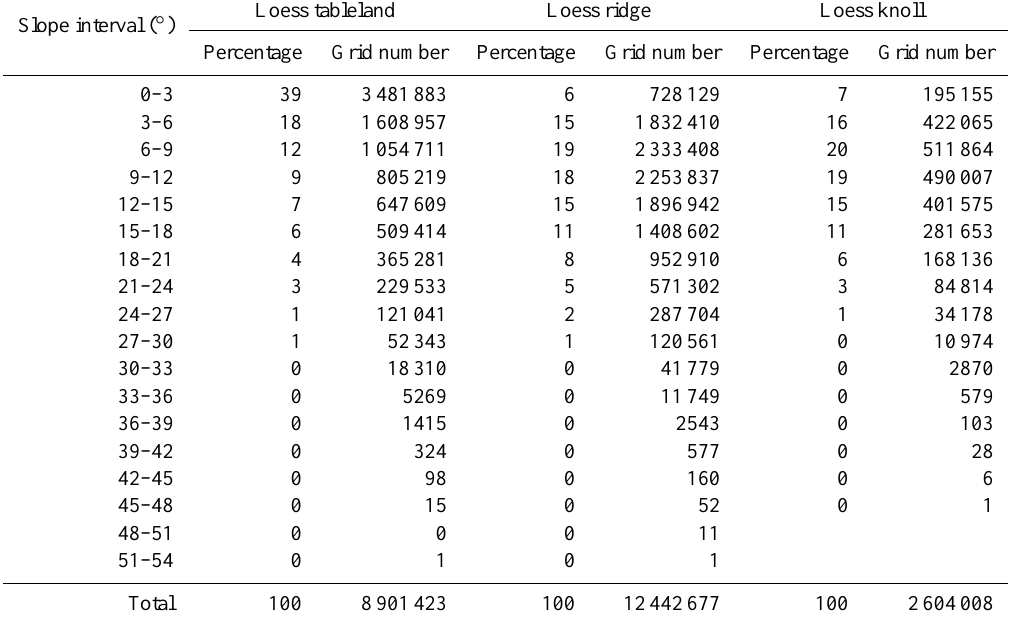
Table 2. Distribution status of the slope intervals for the typical loess geomorphologic types. Slope interval ( ◦ )